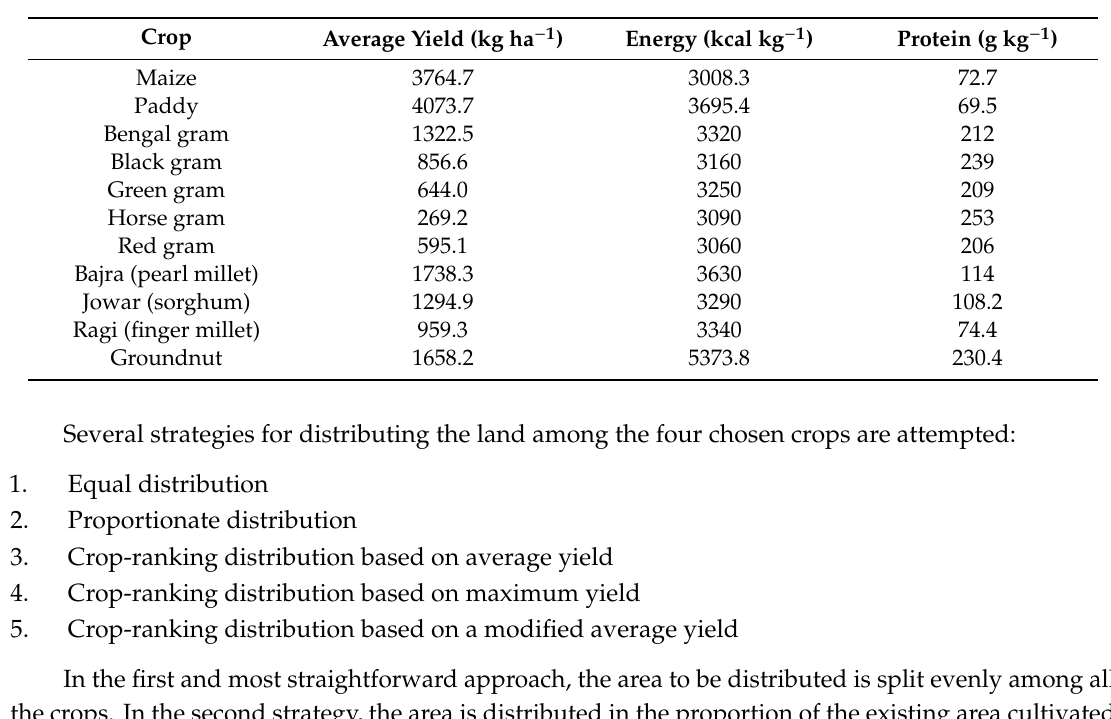
Table 2. Average yields and nutritional content (energy and protein) of various crops. Yield data is the average of yields from 2013–2017 [41]. Data on the nutritional content of various crops obtained from multiple sources